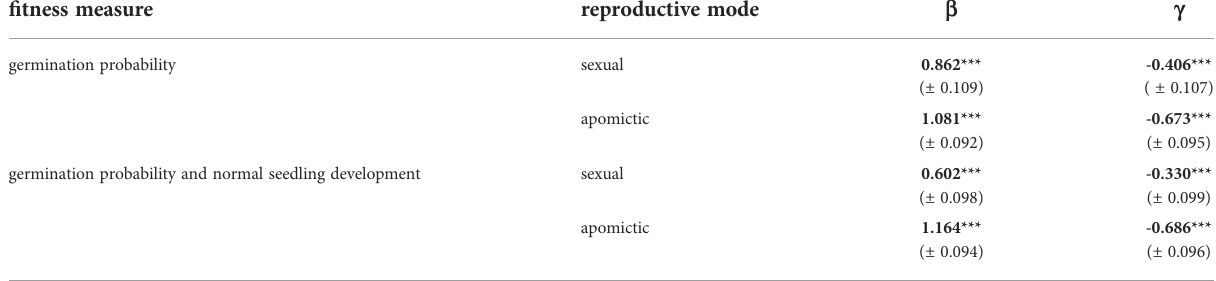
Bold values indicate statistically signi fi cant selection gradients, signi fi cance levels: * < 0.05, ** < 0.01, *** <